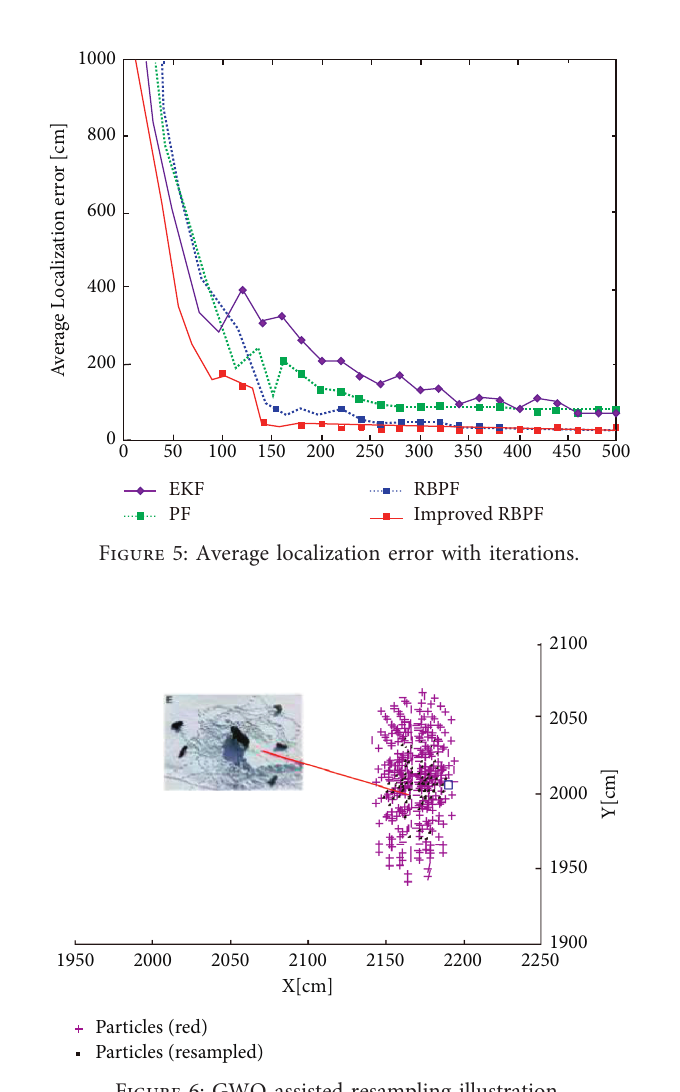
Figure 6: GWO-assisted resampling illustration.